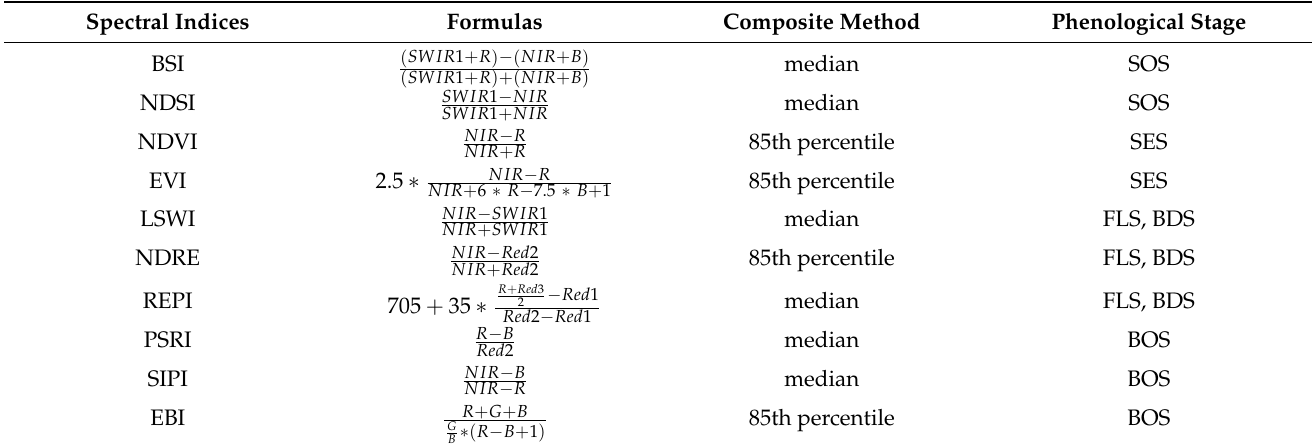
Table 1. Formulas of the selected spectral indices with the corresponding phenological stages.